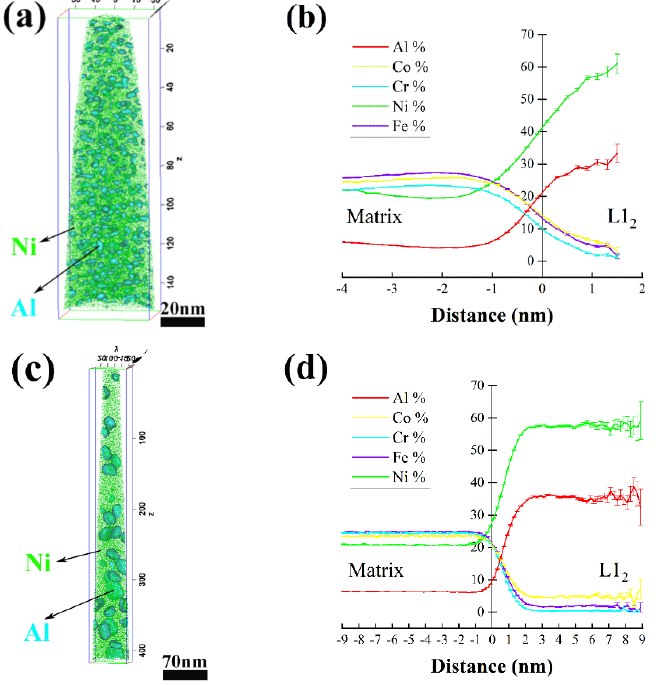
Figure 3. The 3DAP reconstruction images and corresponding concentrations of Al, Co, Cr, Fe and Ni elements between matrix and L1 2 phase at atomic percentage: ( a , b ): AH590 sample; ( c , d ): AH700 sample.